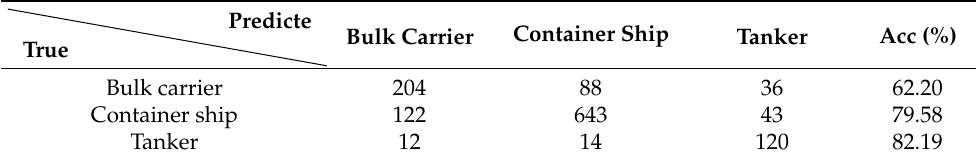
Table 8. Classification confusion matrix of ResNet + HOG on the OpenSARShip-1.0 dataset.